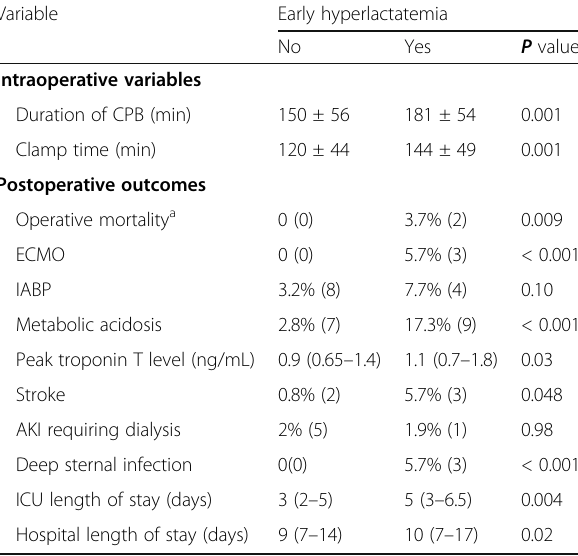
Table 2 Operative profile and postoperative